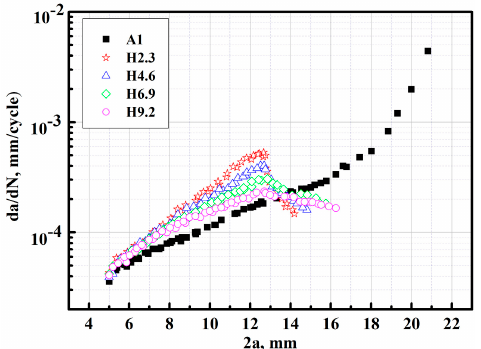
Figure 9. The crack propagation rates plotted with fatigue crack length for specimens H2.3, H4.6, H6.9, and H9.2 compared with specimen A1.